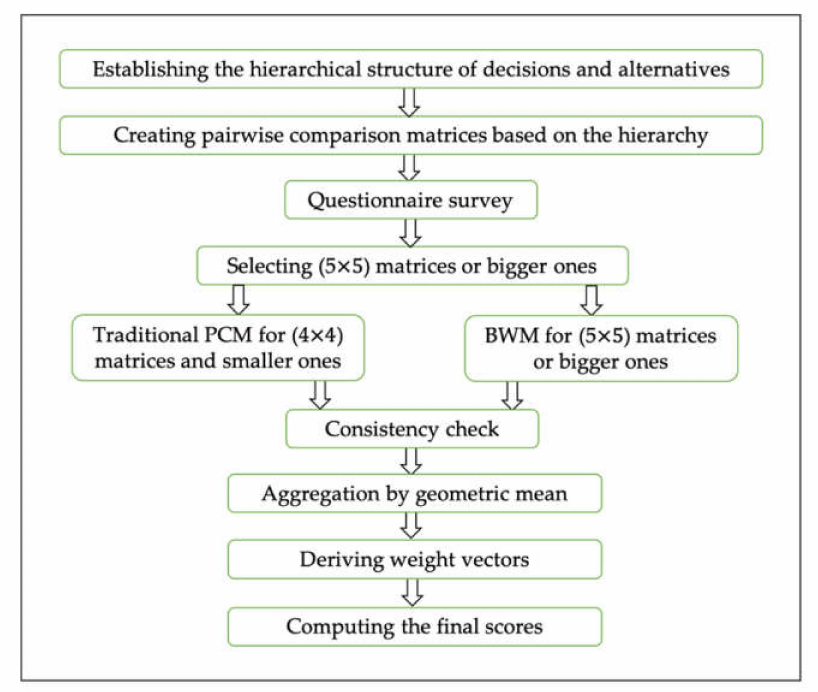
Figure 2. Steps of the proposed Best Worst Method–Analytic Hierarchy Process (BWM–AHP)